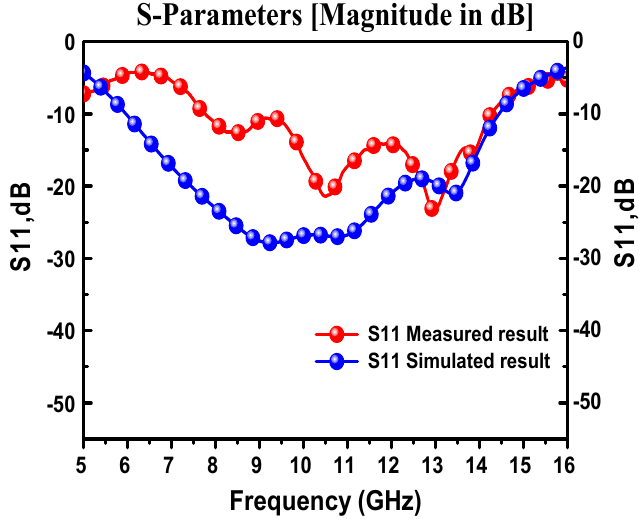
Figure 10. Simulated and measured results of return loss for CPW-fed antenna design.